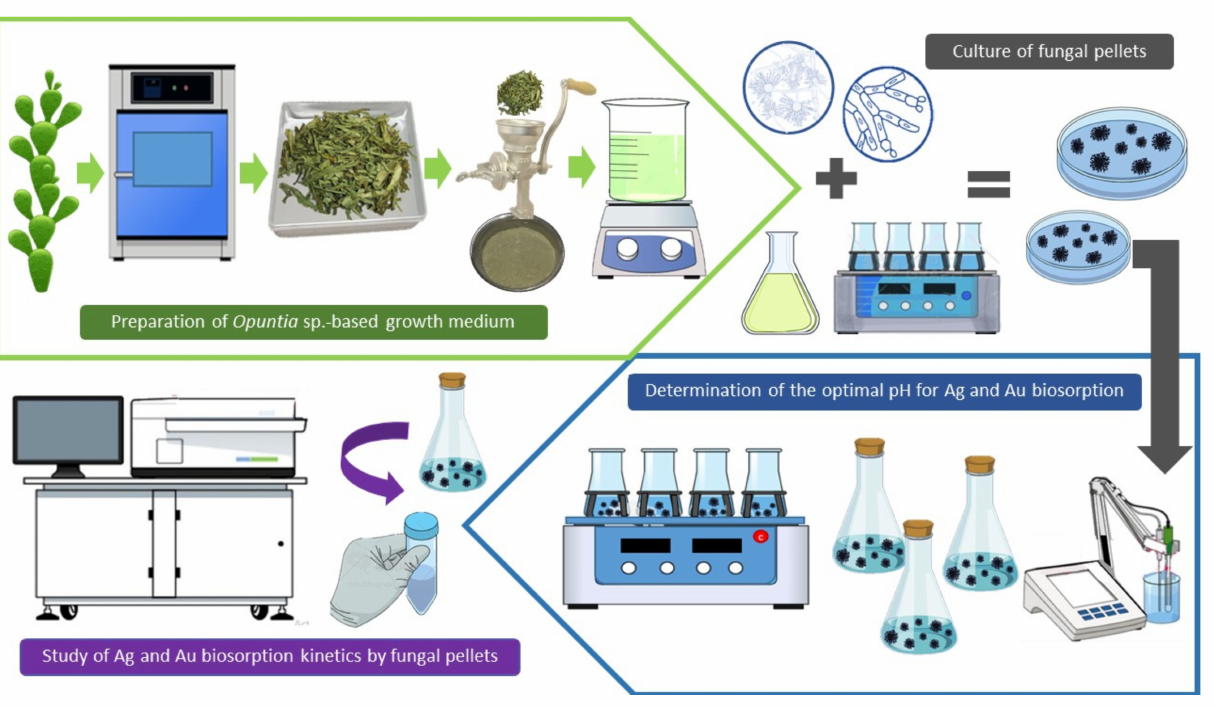
Figure 1. Methodology of this